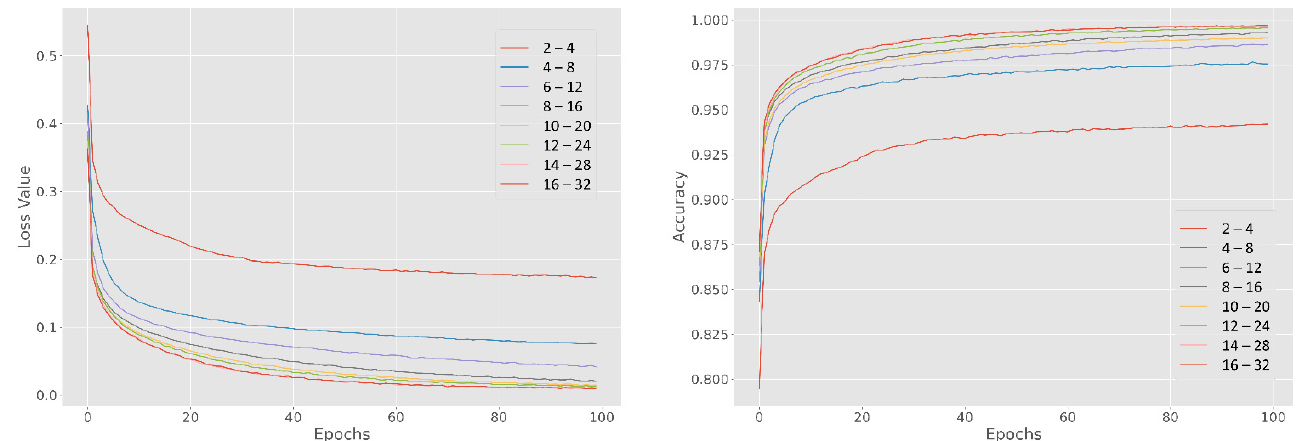
Figure 4. Model loss and accuracy on training the ResNet-18 model over 100 epochs.